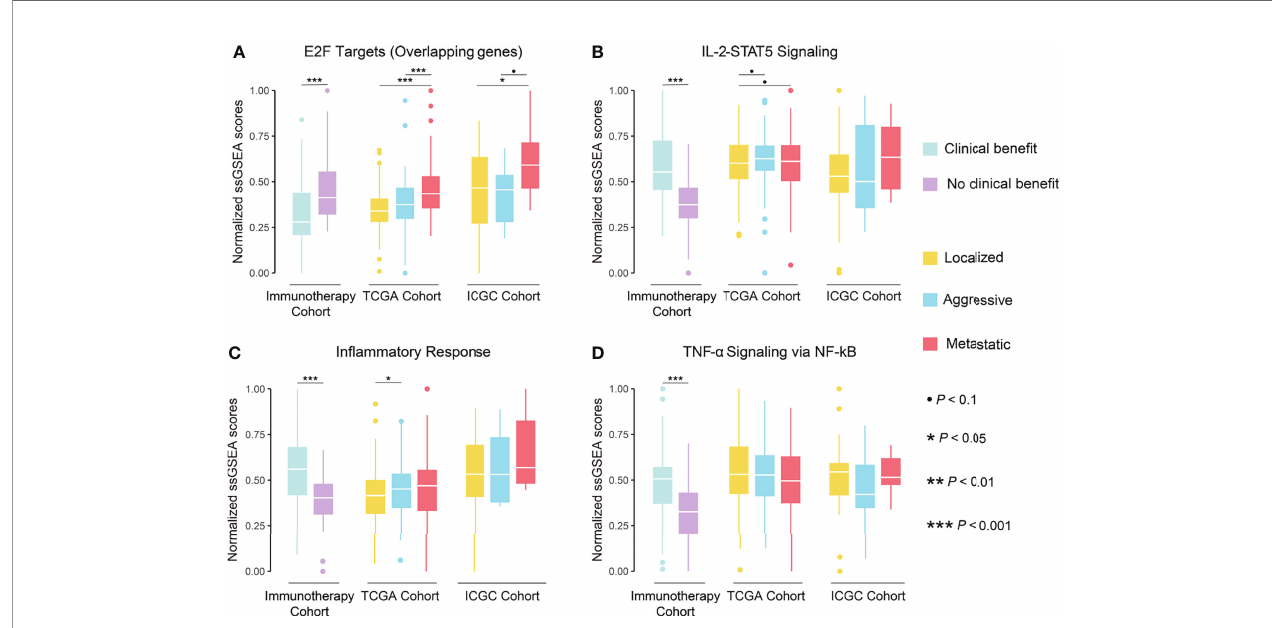
FIGURE 10 | Boxplot showing the differences in normalized ssGSEA scores of overlapping genes of E2F targets pathway (A) , IL-2-STAT5 signaling pathway (B) , in fl ammatory response pathway (C) , and TNF- a signaling via NF-kB pathway (D) between phenotypes in TCGA and ICGC cohorts and between groups in immunotherapy